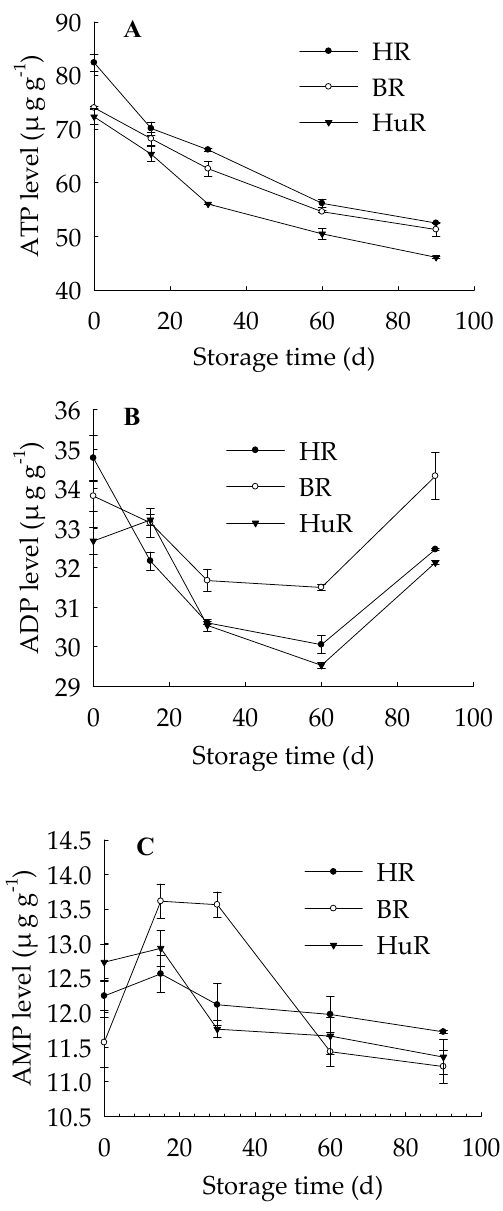
Figure 3. Changes in ATP ( A ), ADP ( B ), AMP ( C ) levels in juice sacs of three pumelo cultivars. Vertical bars represent SE of the means of three replicate